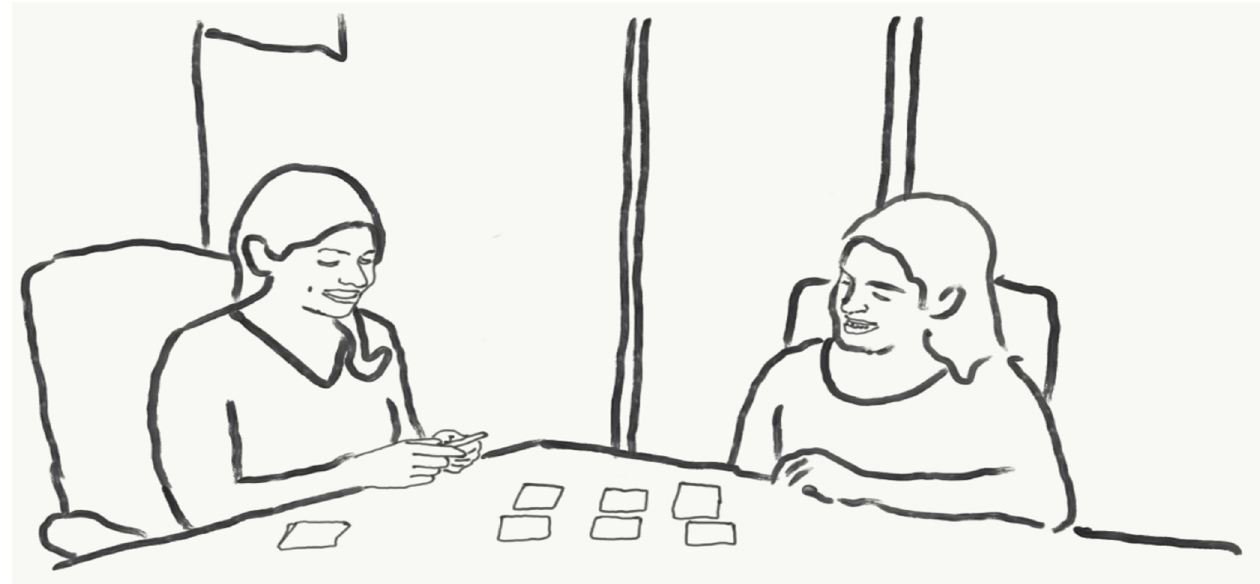
Figure 5. Sketch of facilitator ( left ) interacting with a human subject ( right ) during an in-person trial.